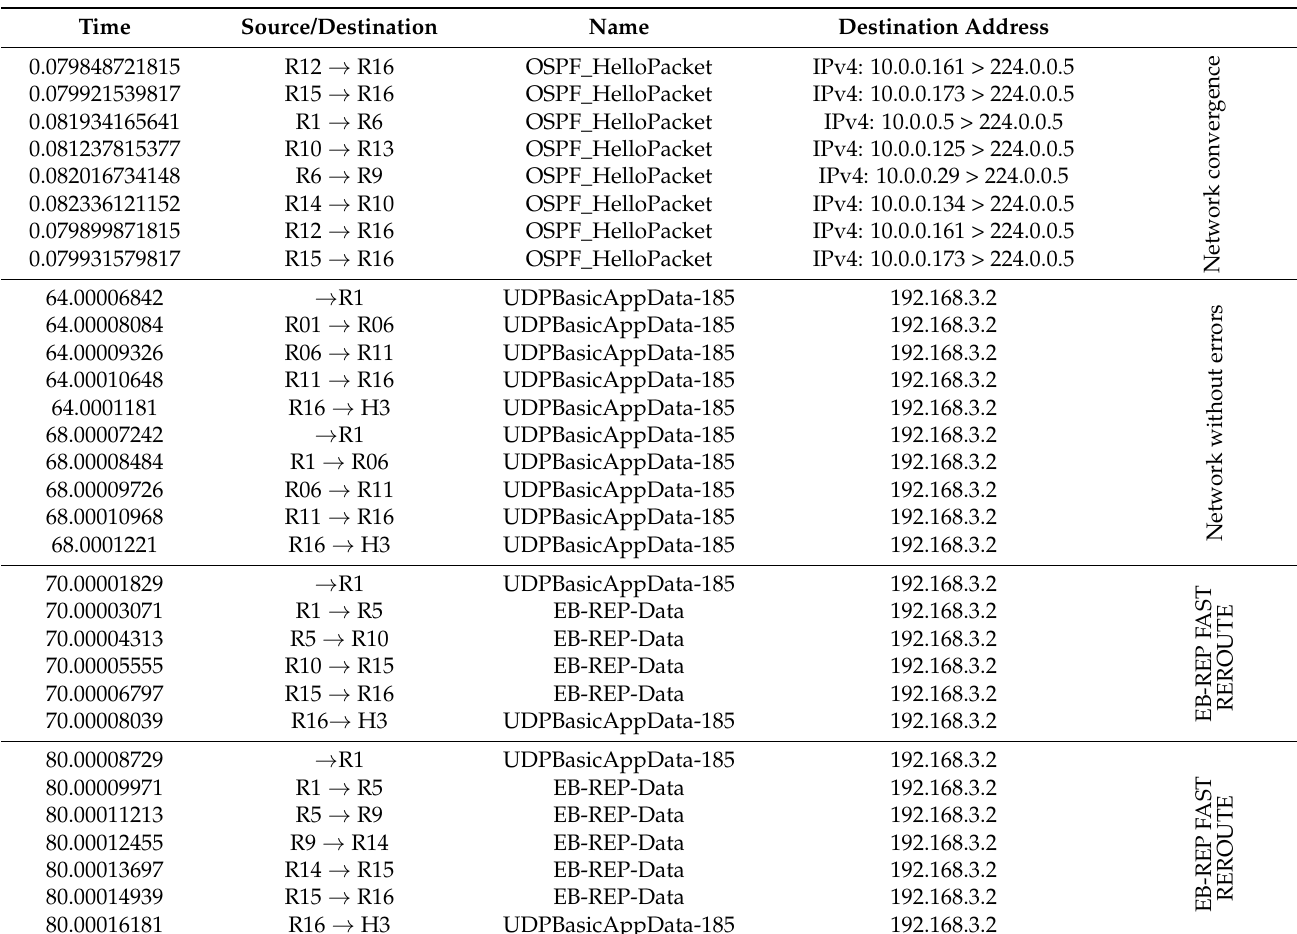
Table 11. Output from the OMNeT++